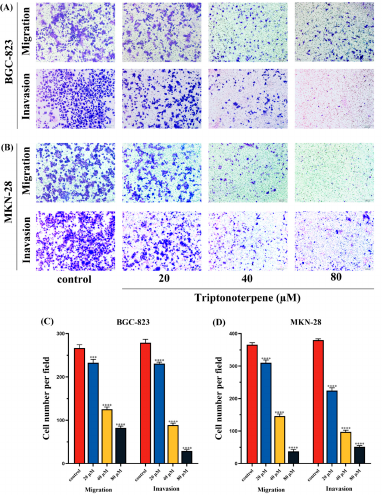
Figure 5. The invading and metastatic ability of the GC cells was examined using the Transwell assay. ( A ) Number of the BGC-823 cells migrating and invading under the microscope. ( B ) Number of the MKN-28 cells migrating and invading under the microscope. ( C ) Statistical chart of the number of migrating and invading BGC-823 cells. ( D ) Statistical chart of the number of migrating and invading MKN-28 cells. *** p < 0.001 and **** p <